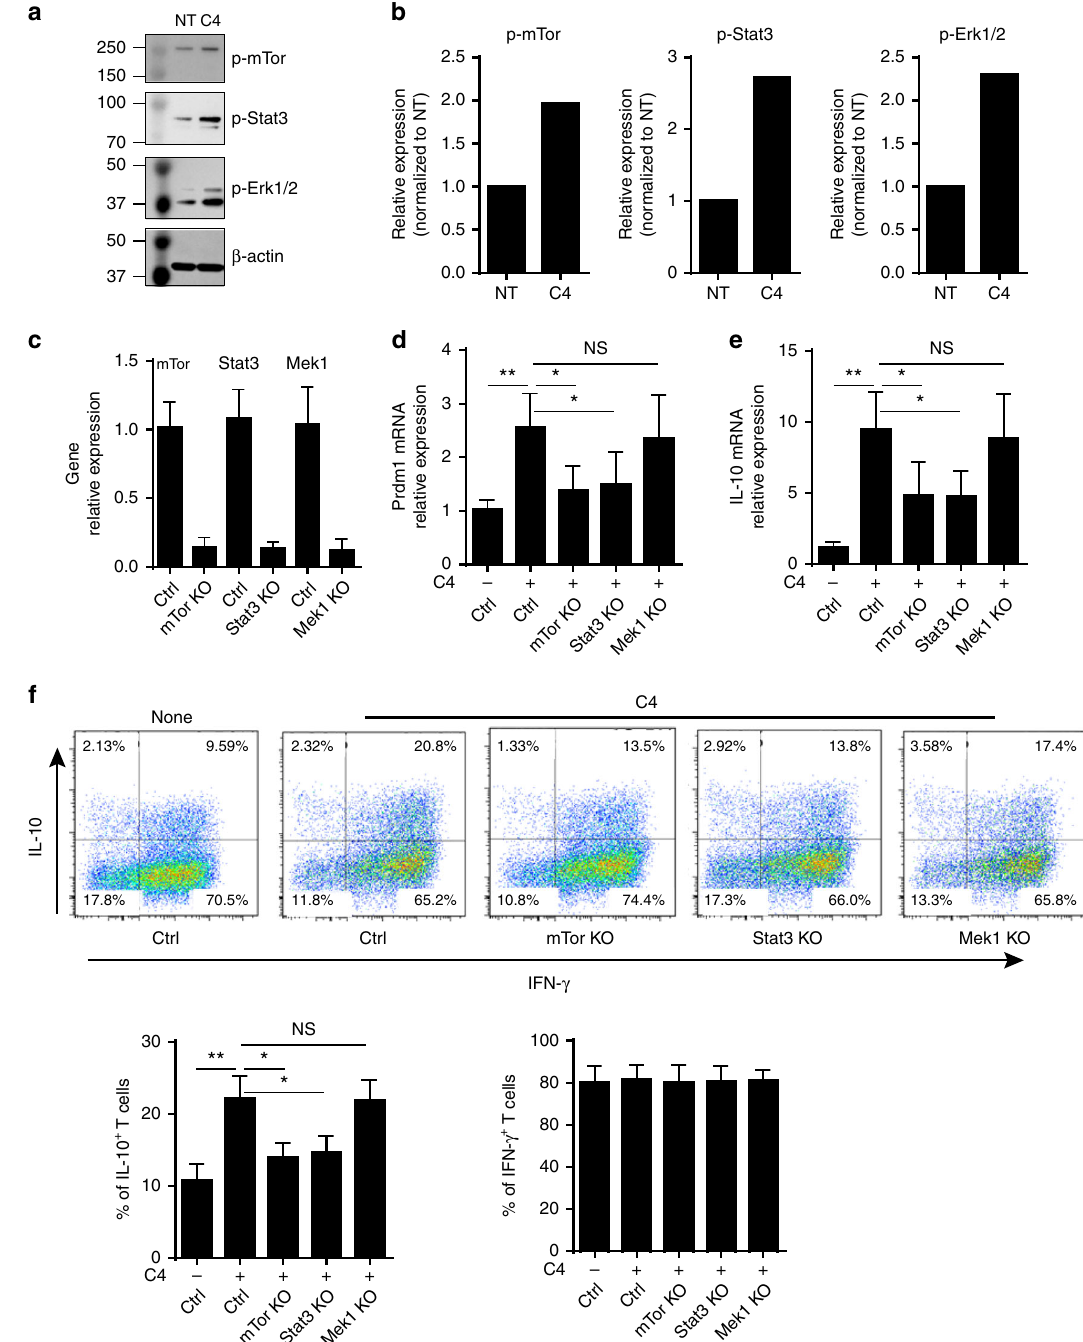
Fig. 7 STAT3 and mTOR mediate Butyrate-induction of Th1 cell expression of Blimp-1 and IL-10. a , b Th1 cells were cultured with anti-CD3 and anti-CD28 mAbs in the presence or absence of C4. The cell lysates were prepared, and Western blot was used to determine p-mTOR (S2448, 15 min), p-SATA3 (Y705, 15 min), and p-ERK1/2 (137F5, 15 min), with β -actin as reference. c – f Th1 cells were transfected with lentiCRISPR plasmids to knock out Stat3, mTor, and Mek1. After 24 h, the expression of relative genes ( c ) was examined by qRT-PCR. The cells were cultured with anti-CD3 and anti-CD28 mAbs in the presence or absence of C4 ( n = 3/group). The expression of Prdm1 ( d ) and IL-10 ( e ) was examined at day 2 by qRT-PCR. f T-cell cytokine production was determined at day 5 by FACS. Both representative FACS pro fi le and barchart of IL-10 + and IFN γ + T-cells were shown. The results are shown as mean ± SD of three samples and are representative from one of three experiments performed. * p < 0.05, ** p < 0.01 one-way ANOVA